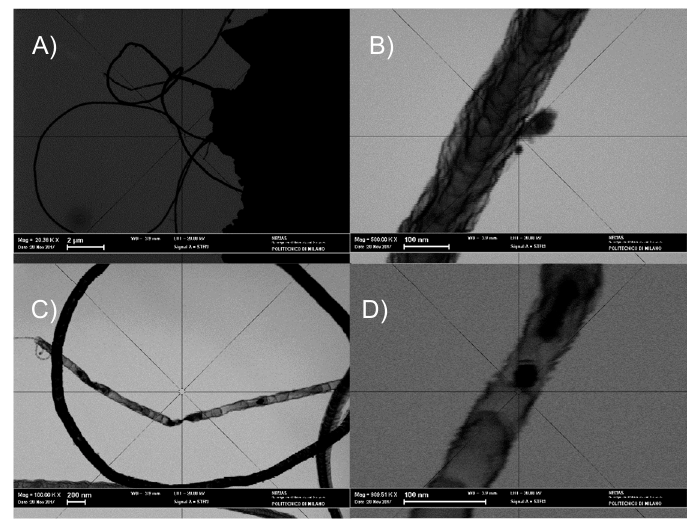
Figure 6. STEM images of S_GA_Fe. ( A ) Overview; ( B – D ) Details of ( A ). Polarization curves in 0.1 mol dm − 3 KOH are reported in Figure 7 and elaborated data are displayed in Table 4. A polarization curve for a commercial catalyst based on Pt (EC20, 20% Pt) and relative data are also shown for comparison.